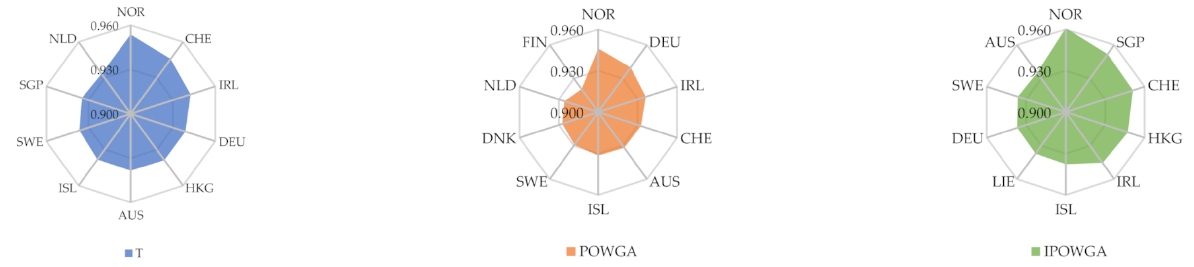
Figure 2. Comparison of the proposed methods for the top 10 countries.